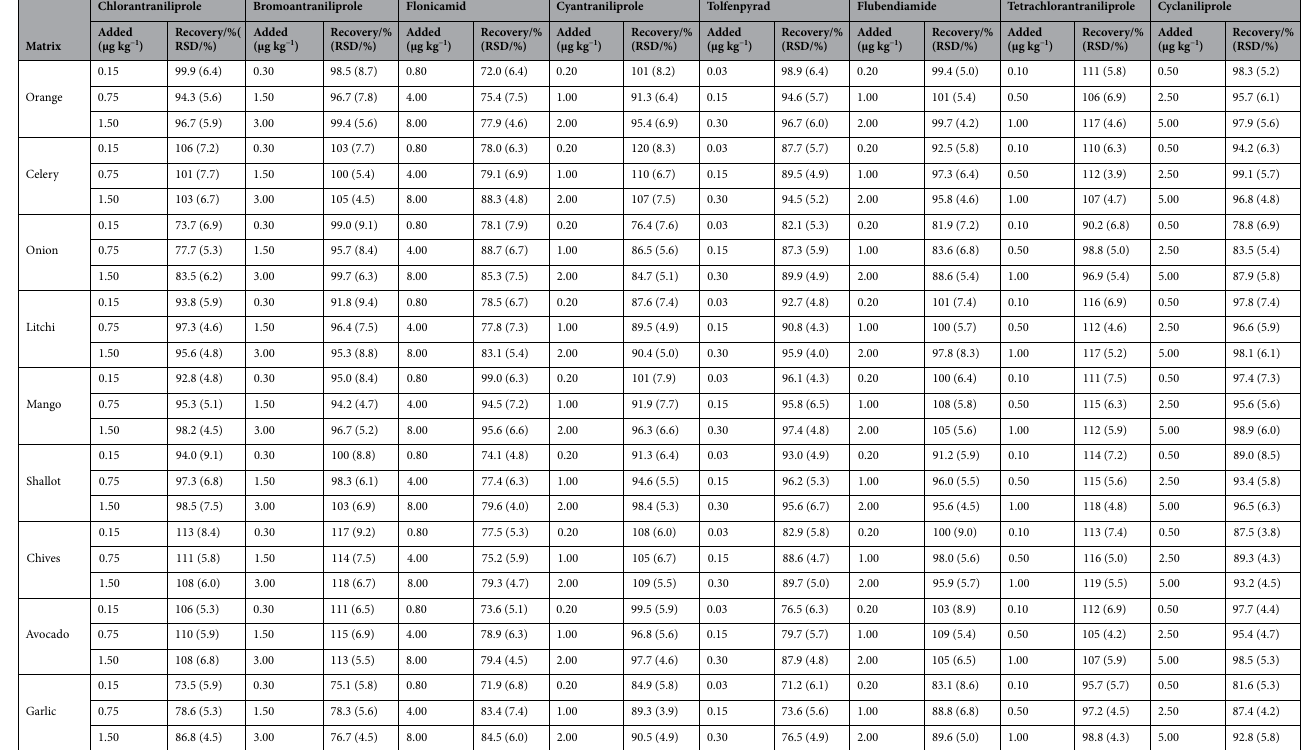
Table 3. Recoveries and relative standard deviations of amide